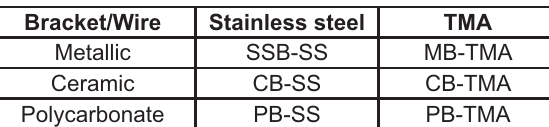
Figure 1- Systems assessed and their